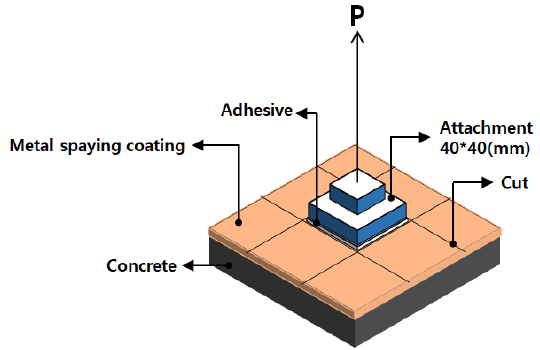
Figure 1. Schematic for bond adhesion measurement.